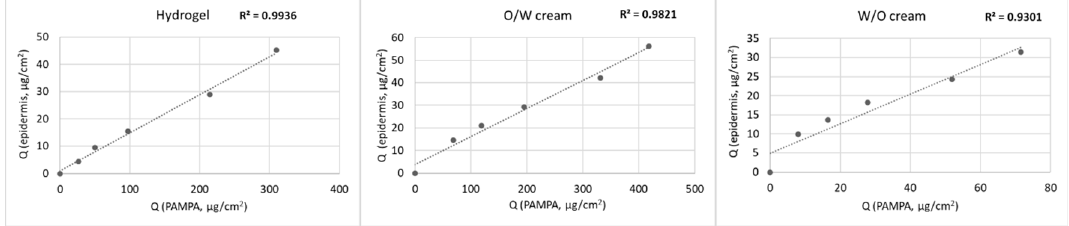
Figure 2. Diclofenac sodium permeation, time point correlations between the amounts of drug penetrated through heat-separated human epidermis and skin PAMPA membrane.